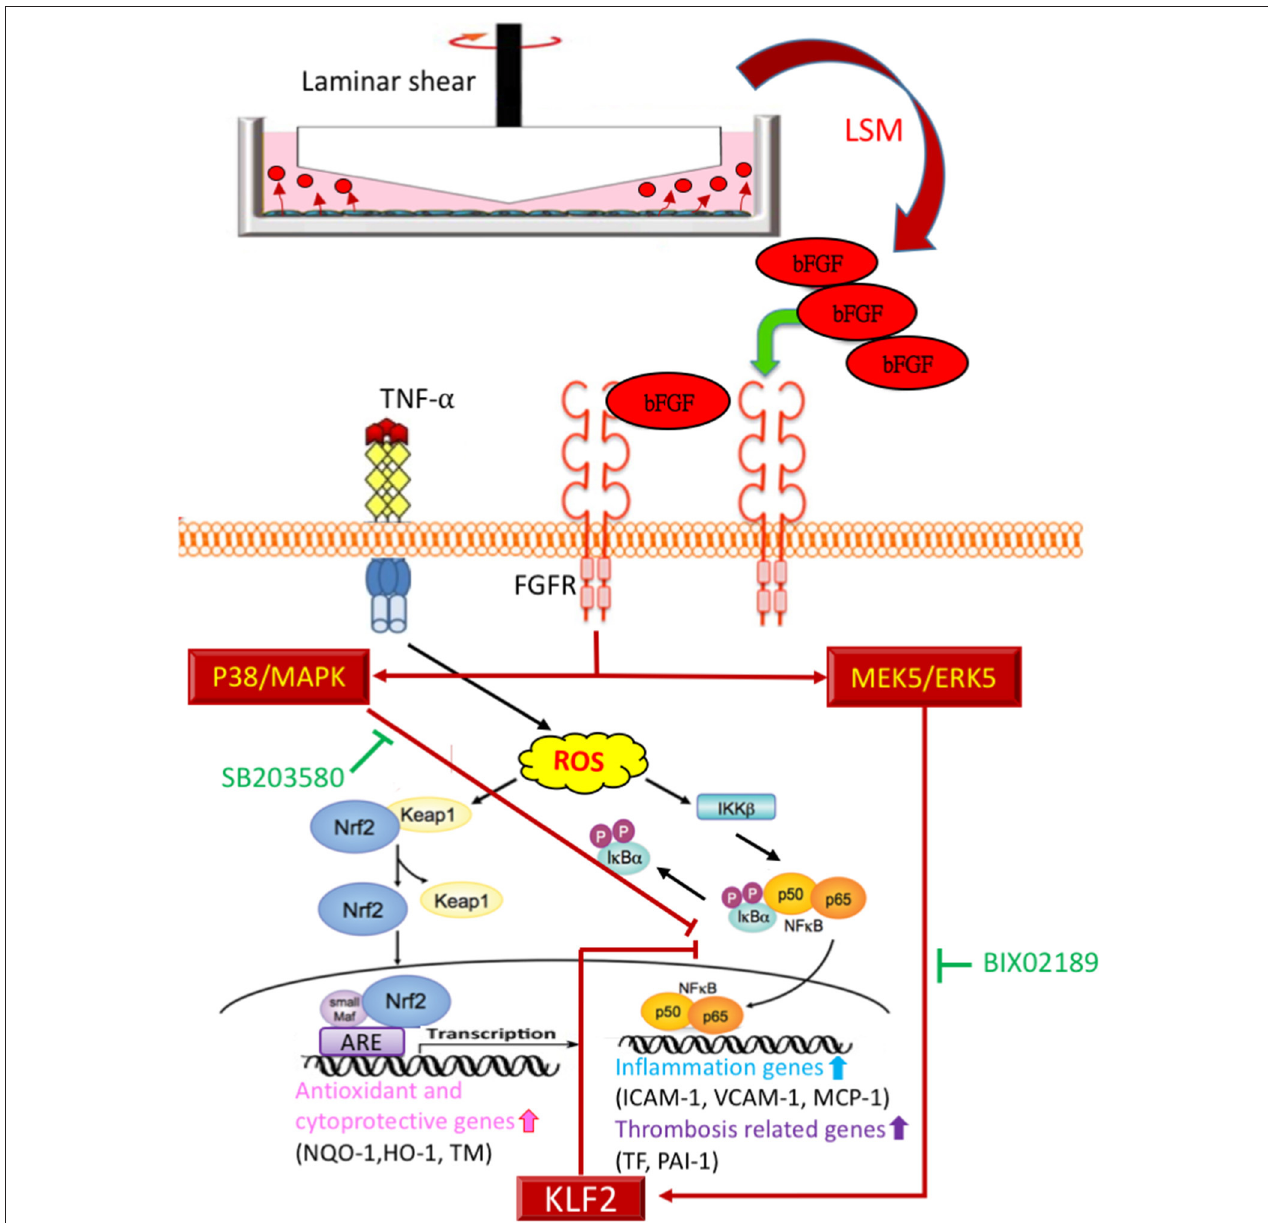
FIGURE 9 | Proposed model of cytoprotective mechanism of bFGF in TNF- α stimulated endothelial dysfunction via p38-MAPK and MEK5/ERK5-KLF2